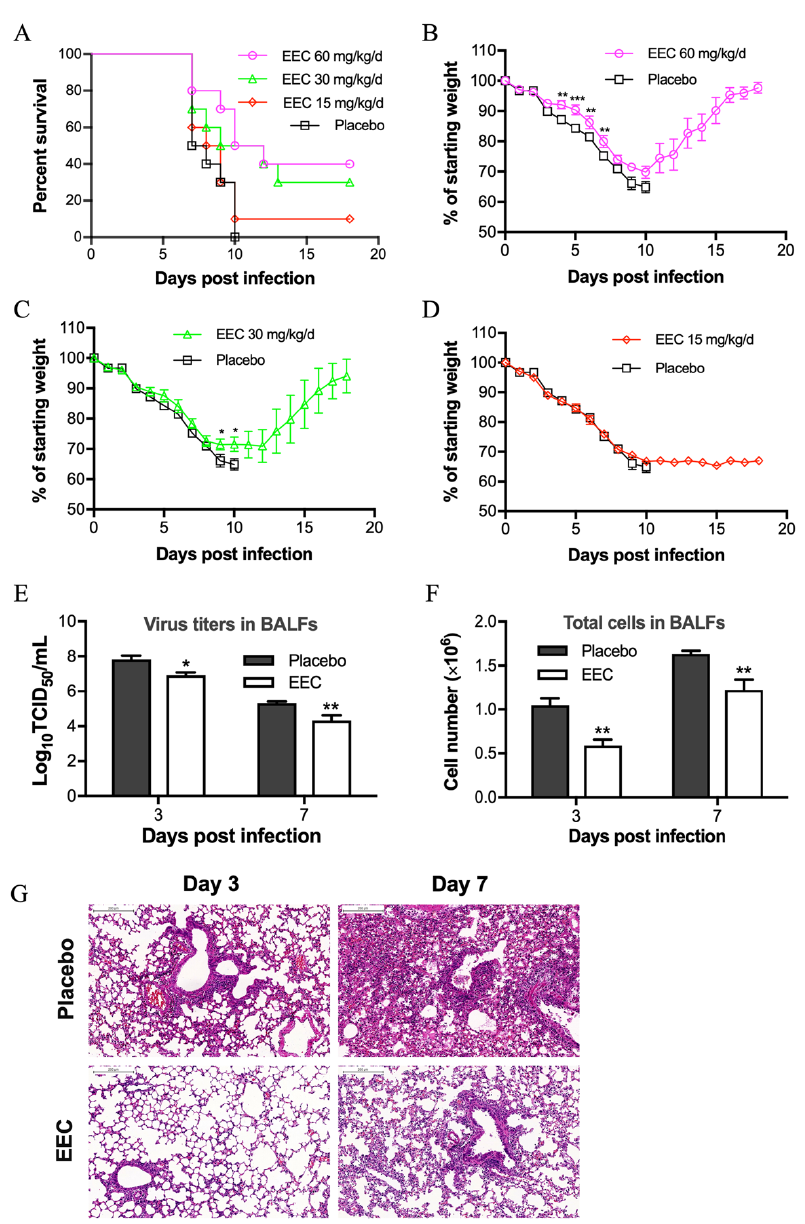
Figure 4. EEC protects mice from lethal influenza virus infection. Six-week-old female BALB / c mice weighing 16–18 g were infected with 4 LD 50 of H1N1 PR8 virus intranasally. Three hours after infection, four groups of mice (10 mice in each group) were treated intraperitoneally with 60, 30, 15 mg / kg / d of EEC or placebo solution respectively for five consecutive days. Survival rate ( A ) and body weight loss ( B – D ) were monitored daily until day 18 post-infection. Lung lavage fluids (BALFs) from the infected mice treated with 60 mg / kg / d of EEC were collected on days 3 and 7 post-infection to monitor virus titers ( E ), and total cell counts ( F ) (mean ± SEM). The data are representative of three independent experiments. ( n = 3 per group at each time point). * p < 0.05; ** p < 0.01; *** p < 0.001. Sections from lungs of PR8-infected BALB / c mice treated with 60 mg / kg / d of EEC or placebo solution at day 3 and 7 post-infection were H&E-stained (scale bar 200 µ m) ( G